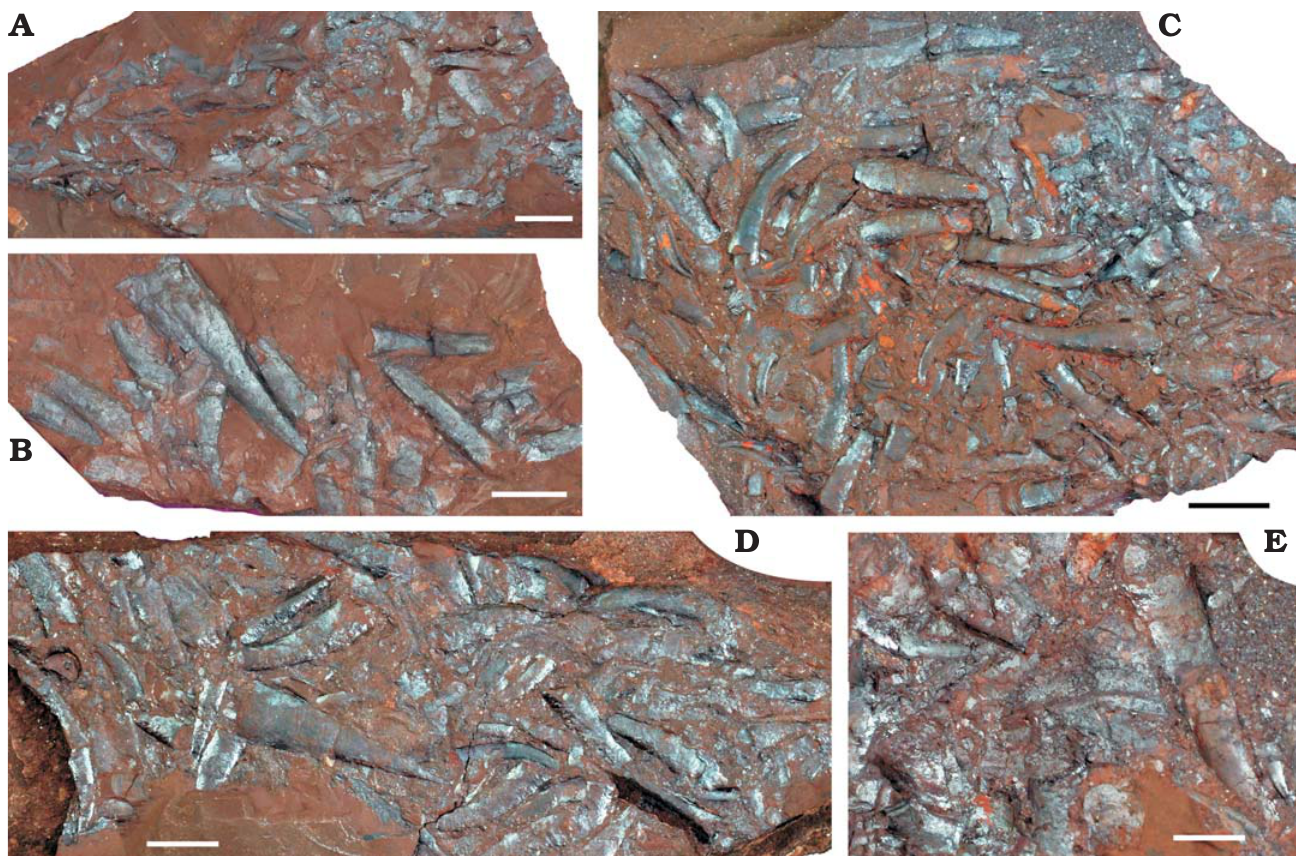
Fig. 1. Aggregations of orthothecide hyoliths preserved in purplish-red shales from the Manto Formation (Cambrian Stage 4/5) in the Zuojiawu section of Tangshan, China. A . NIGPAS 166336. B . NIGPAS 166345. C . NIGPAS 166334. D . NIGPAS 166341b. E . NIGPAS 166346. Scale bars 5 mm, except E, 2